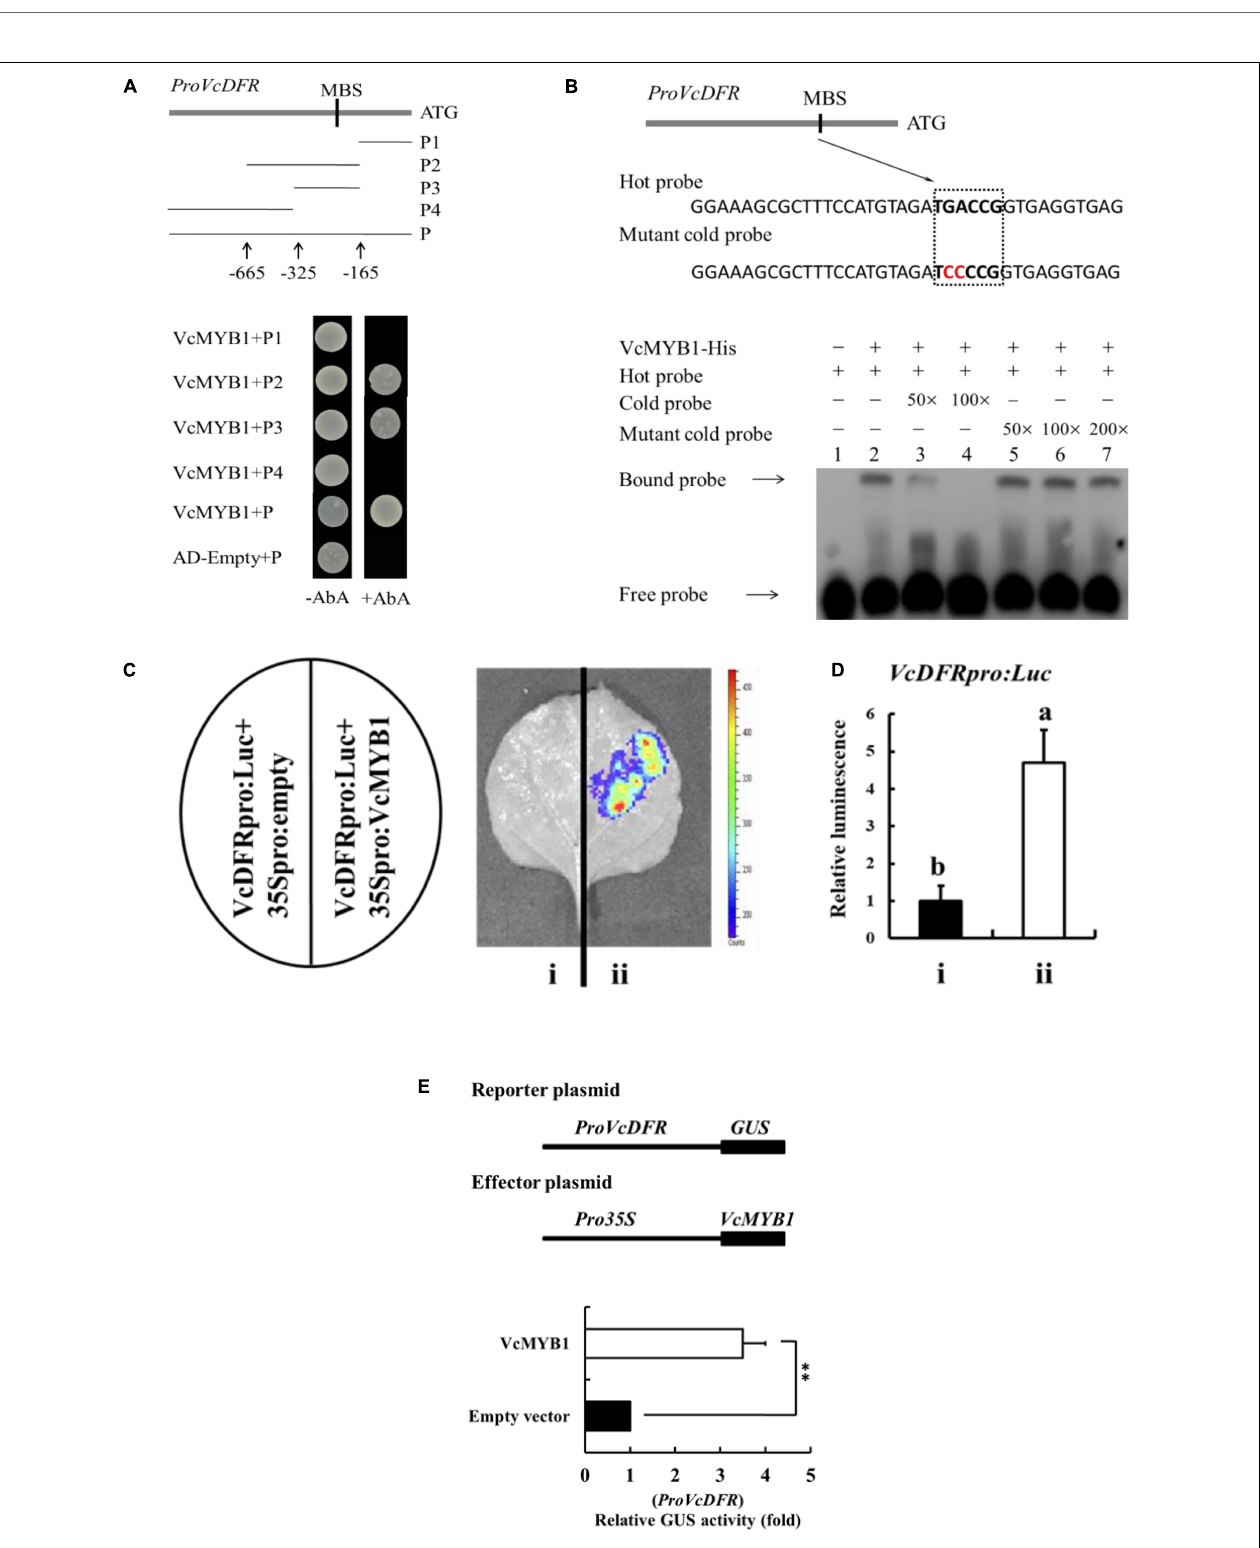
FIGURE 6 | VcMYB1 can directly bind to and activate the VcDFR promoter. (A) Y1H analysis showed that VcMYB1 can bind to VcDFR promoter fragments that contain the MBS motif. The VcDFR promoter was divided into four segments (P1–P4). AbA (Aureobasidin A) is a growth inhibitor of yeast cells and was used as a screening marker. The screening concentration for AbA was 100 ng/mL. The empty vector and the full-length VcDFR promoter were used as a negative control. (B) EMSA analysis showed that VcMYB1 can bind to the MBS motif on the VcDFR promoter. The hot probe contains a VcDFR promoter with a biotinylated